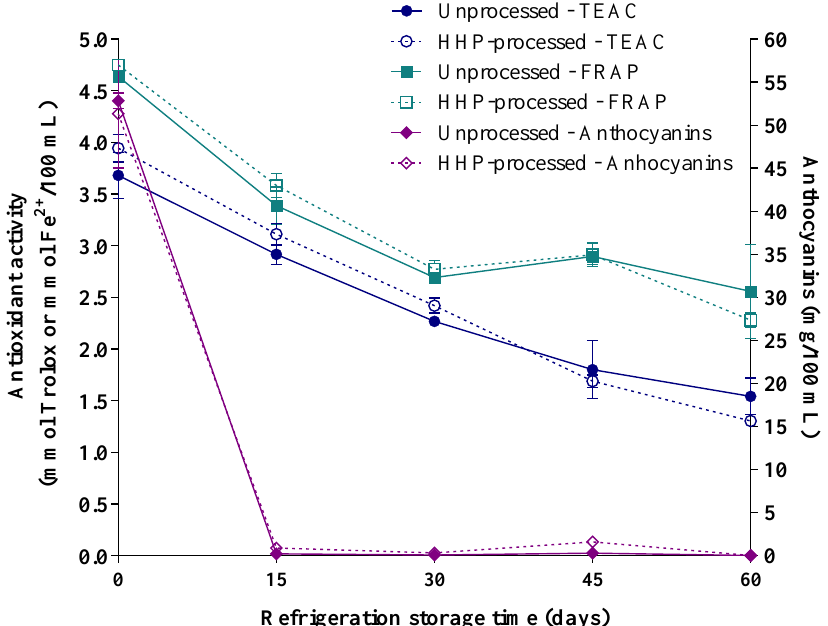
Figure 5. Storage of jussara juice for 60 days of refrigeration caused losses of both anthocyanins and antioxidant activity, assessed by FRAP and TEAC assays ( p < 0.0001). While HHP processing at 200 MPa for 5 min affected the loss of TEAC values during storage ( p = 0.021), no effect was observed for the losses of anthocyanins and FRAP values ( p > 0.780) (repeated measures two-way ANOVA).